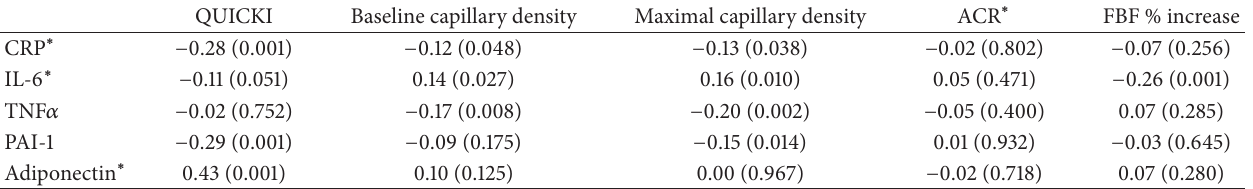
Table 3: Correlations ( 𝑝 values) between inflammation measures and insulin sensitivity, microvascular structure and function, and endothelial